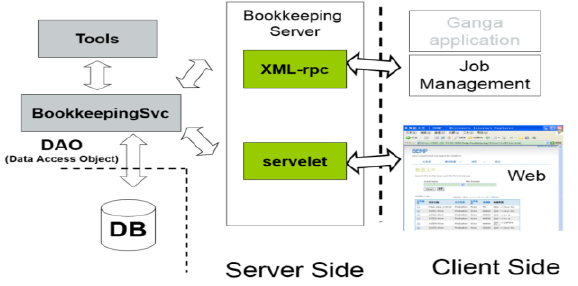
Fig. 5. The structure of BEMP